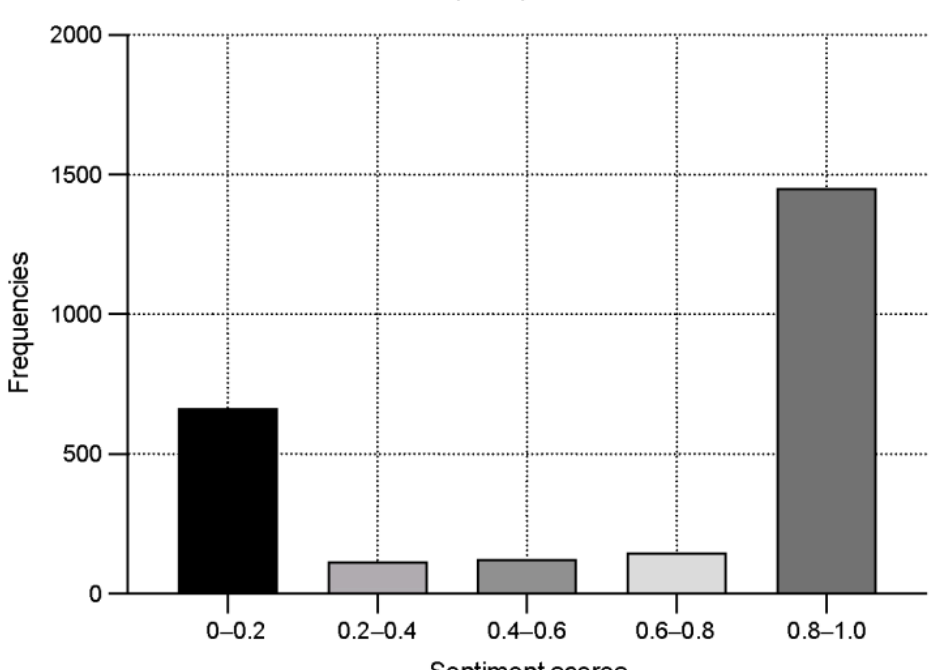
Figure 5. Sentiment score of UGSs in Otsu.